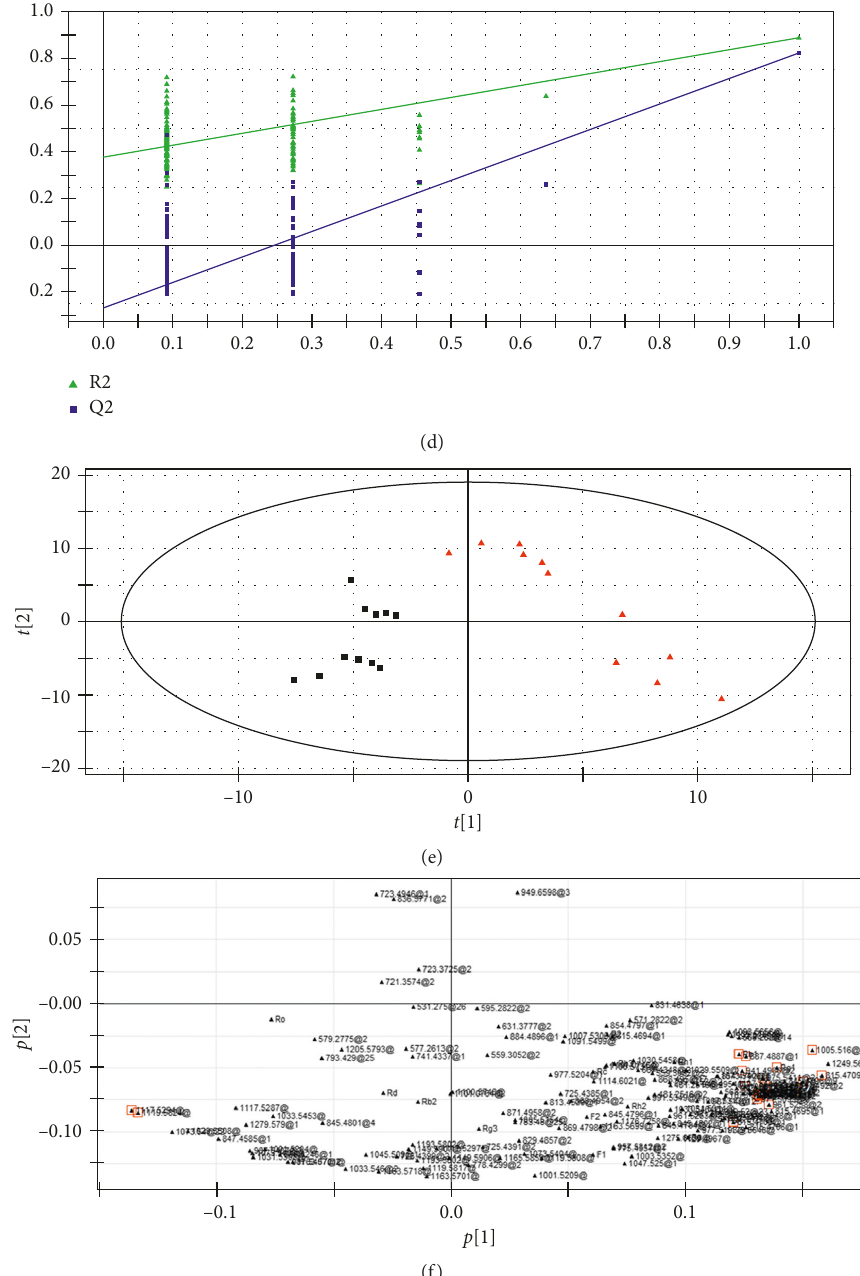
Figure 4: (a) Score plot and (b) loading plot of PCA model based on data of eighteen ginsenoside contents in CGLS, FGLS, and AMGLS. (c) Score plot of PLS-DA model based on data of eighteen ginsenoside contents in CGLS and FGLS. (d) Permutation test, (e) score plot, and (f) loading plot of PLS-DA model based